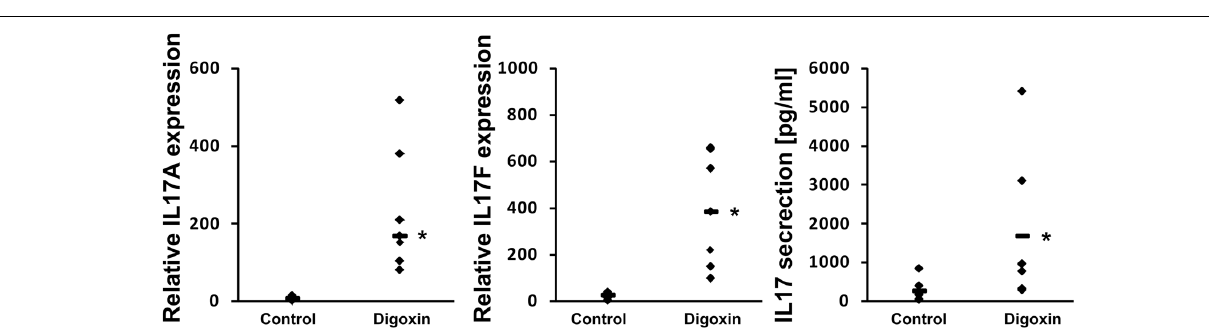
FIGURE 6 | Effect of digoxin on the expression of ROR γ T-dependent genes in human Th17 cells. Human naive CD4+ cells were treated with 100 nM digoxin and then cultured under Th17-polarizing conditions for 5 days. After that time, cells were collected for RNA extraction and supernatants were collected for IL-17 secretion analysis. The expression of the IL17A and IL17F genes was determined by real-time RT-PCR and normalized to the housekeeping genes HPRT1 , HMBS , and RPL13A . Analysis of IL-17 production was performed using a Quantikine Human IL-17 Immunoassay kit (R&D Systems). An asterisk indicates a statistically significant difference at p < 0.05 compared with control cells. The data are presented as statistical dot plots with the median value (bars) from seven independent experiments performed using cultures originating from seven different donors ( n =